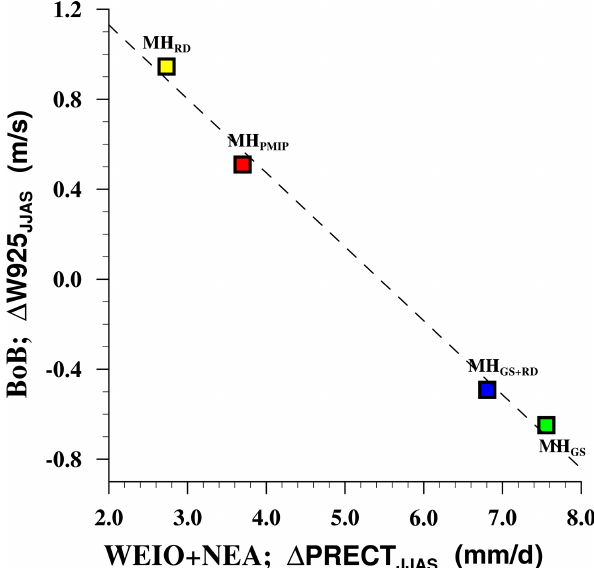
Figure A14. Scatter plot of summer (JJAS) changes between 925hPa wind speed over the Bay of Bengal (BoB, 10–20 ◦ N, 85– 95 ◦ E; m/s) and precipitation over the western equatorial Indian Ocean (WEIO, 5 ◦ S to 5 ◦ N, 50–65 ◦ E; mm/d) and northeastern Africa (NEA, 10–20 ◦ N, 30–45 ◦ E). Linear summation of precipita- tion over the two regions is considered. The changes are shown for the mid-Holocene-only orbital forcing (MH PMIP ) in red, the Sahara greening (MH GS ) in green, dust-only reduction (MH RD ) in yellow, and the Sahara greening with dust reduction (MH GS + RD ) in blue with respect to the PI reference